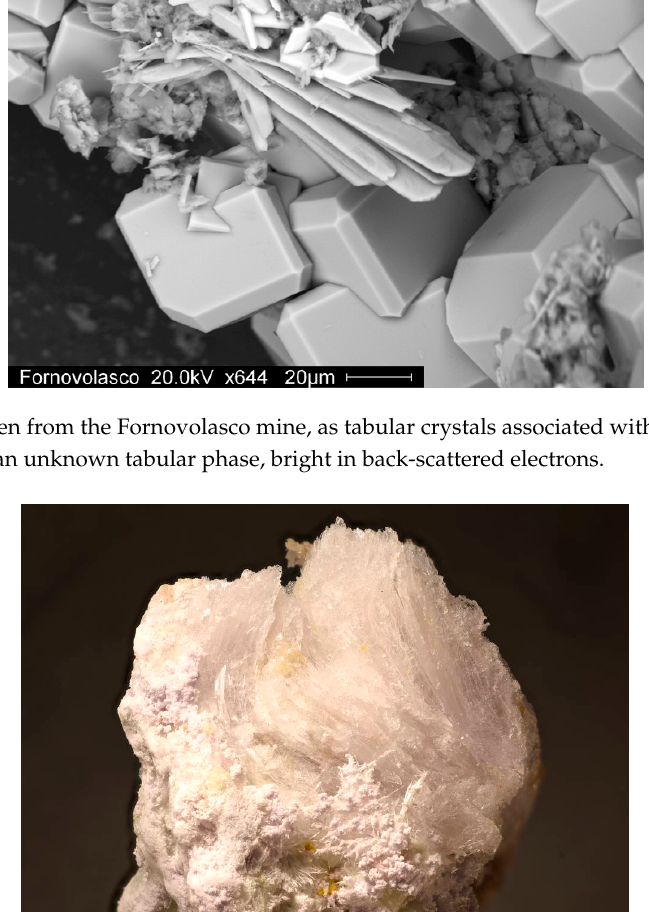
Figure 4. Alunogen from the Fornovolasco mine, as tabular crystals associated with voltaite, in cubic individuals, and an unknown tabular phase, bright in back-scattered electrons.